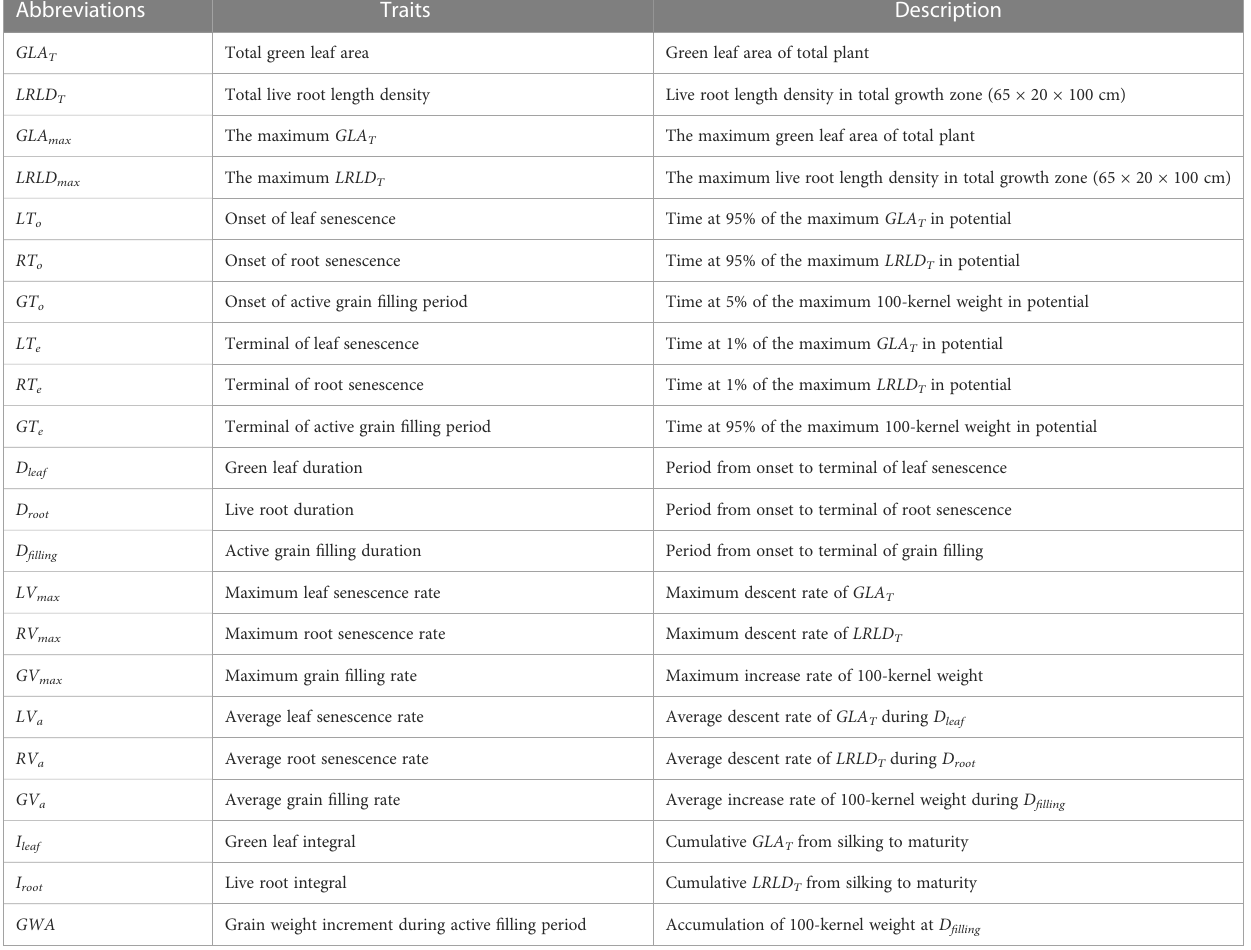
TABLE 2 Abbreviations and descriptions of senescence and fi lling traits estimated from Equations 3 and 4,